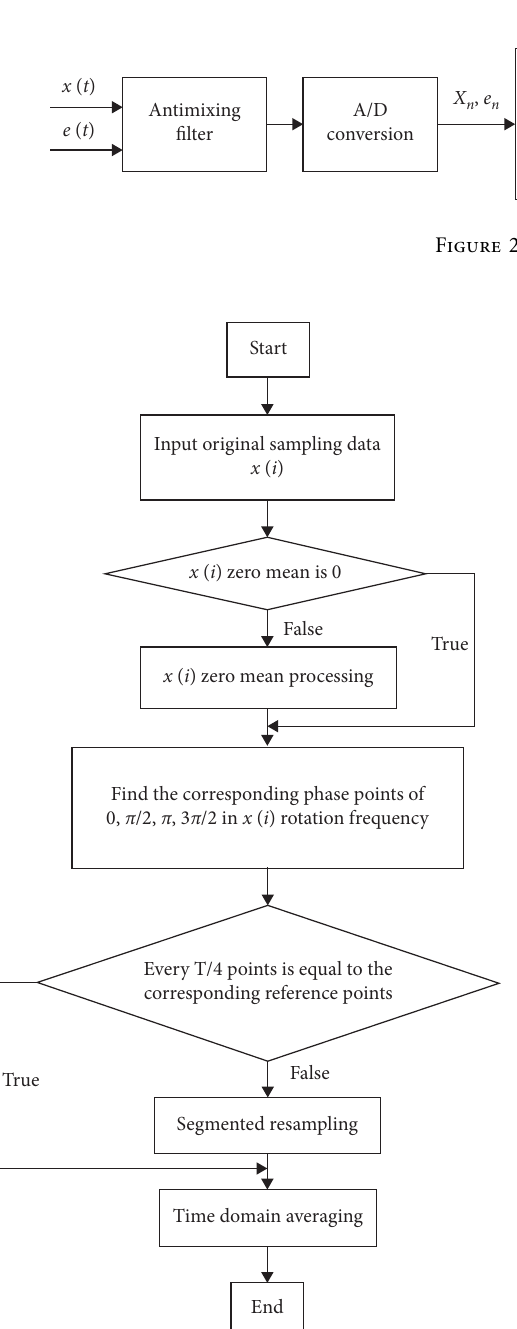
Figure 1: Traditional process.